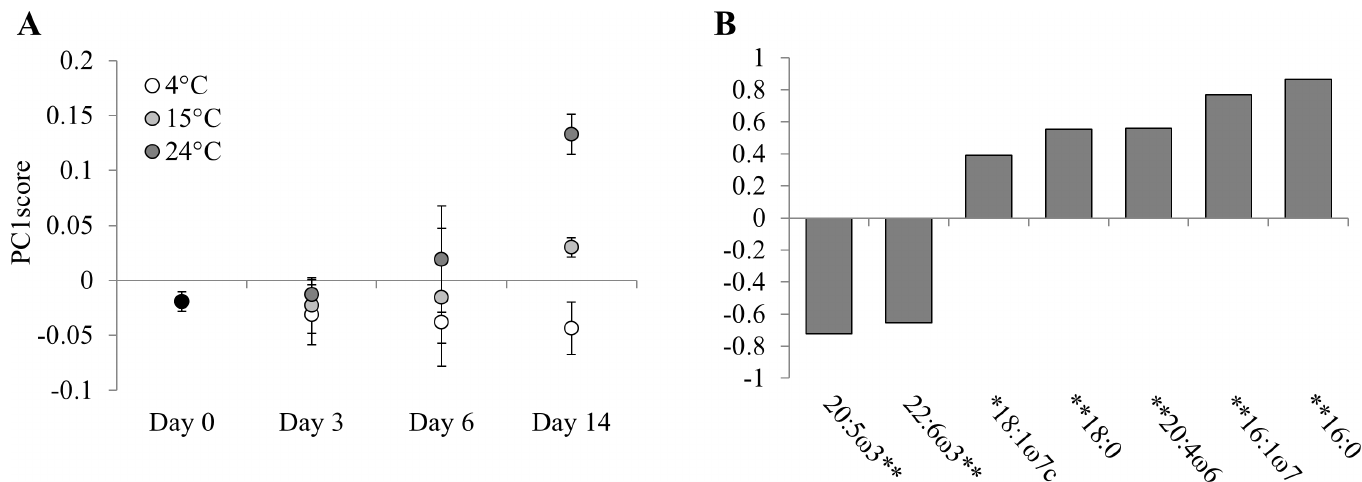
Fig 2. Membrane FA composition of the copepod P . littoralis prior (day 0) and after 3, 6 and 14 days of food deprivation at different temperatures (4, 15 and 24°C). (A) The PC1score values ( ± SD) for membrane lipids are displayed with (B) the Spearman ’ s rho correlation coefficients of individual FAs (%) used for the PCA with the correlation significance levels ( * p < 0.05; ** p < 0.01).